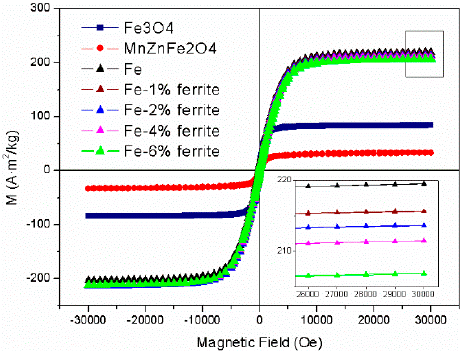
Figure 7. Magnetic hysteresis loops for Fe, Fe/Fe 3 O 4 -MnZnFe 2 O 4 , Fe 3 O 4 , and MnZnFe 2 O 4 powders. Table 1. Magnetic parameters for Fe, Fe/Fe 3 O 4 -MnZnFe 2 O 4 , Fe 3 O 4 , and MnZnFe 2 O 4